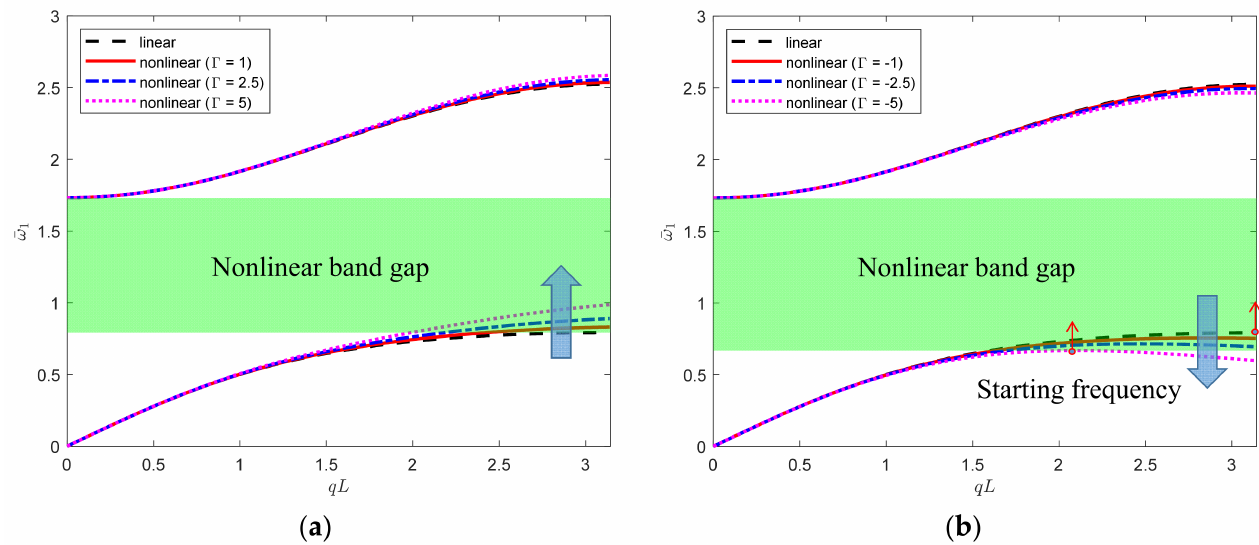
Figure 4. Band structure for a nonlinear mass-in-mass system changing with the degree of nonlinearity: ( a ) The degree of nonlinearity is greater than zero ( Γ > 0). ( b ) The degree of nonlinearity is smaller than zero ( Γ < 0). The fixed amplitude is | A | = 1. The small parameter is set as ε = 0